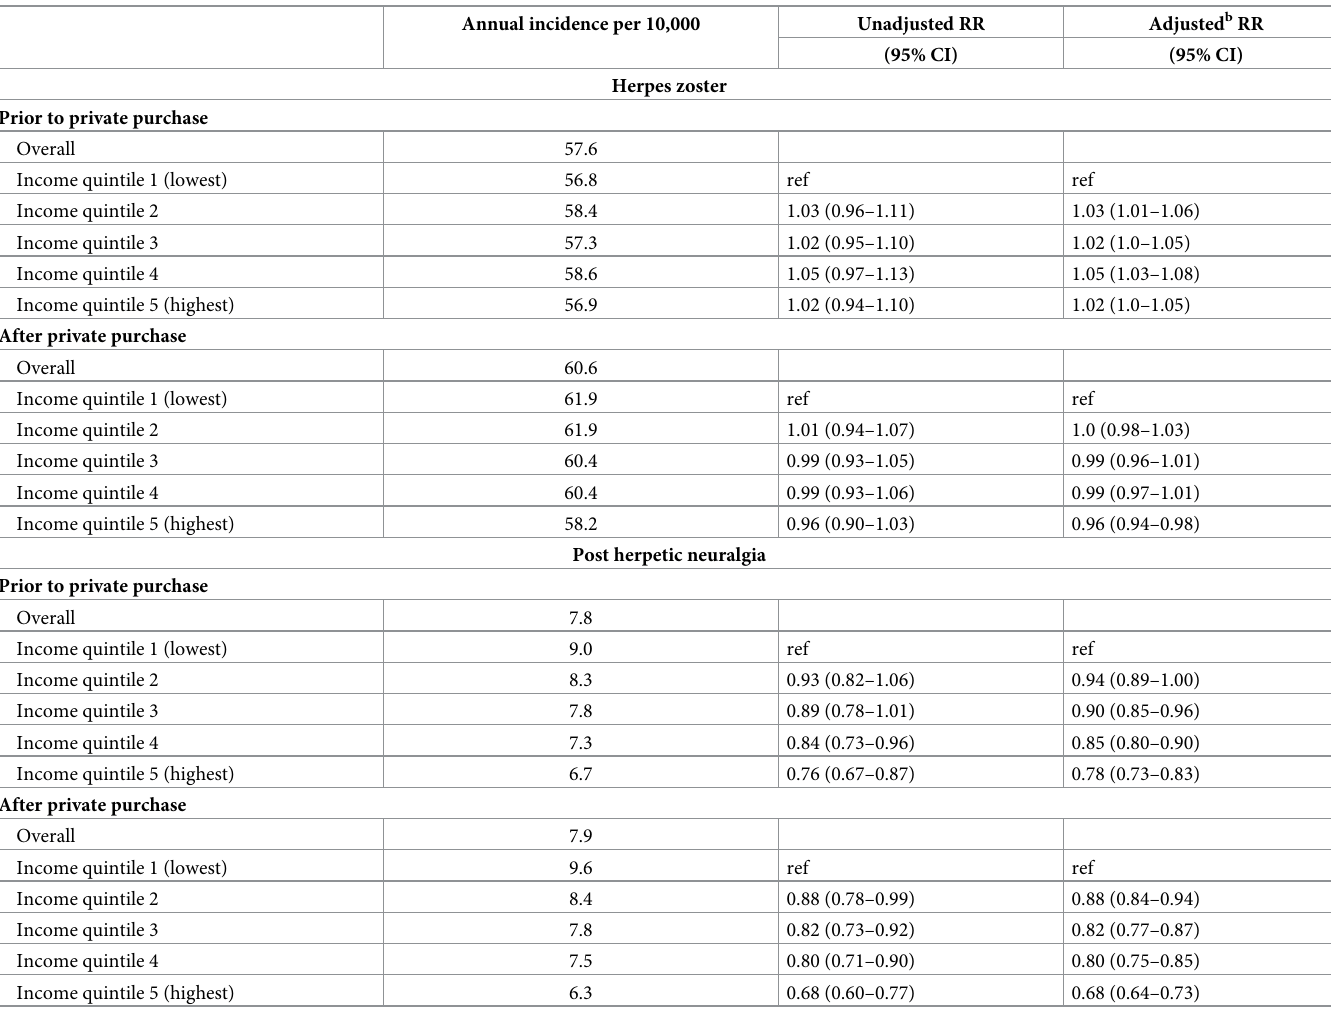
Table 5. Incidence of herpes zoster by income quintile, before and after availability of vaccine through private purchase in those � 65 years a